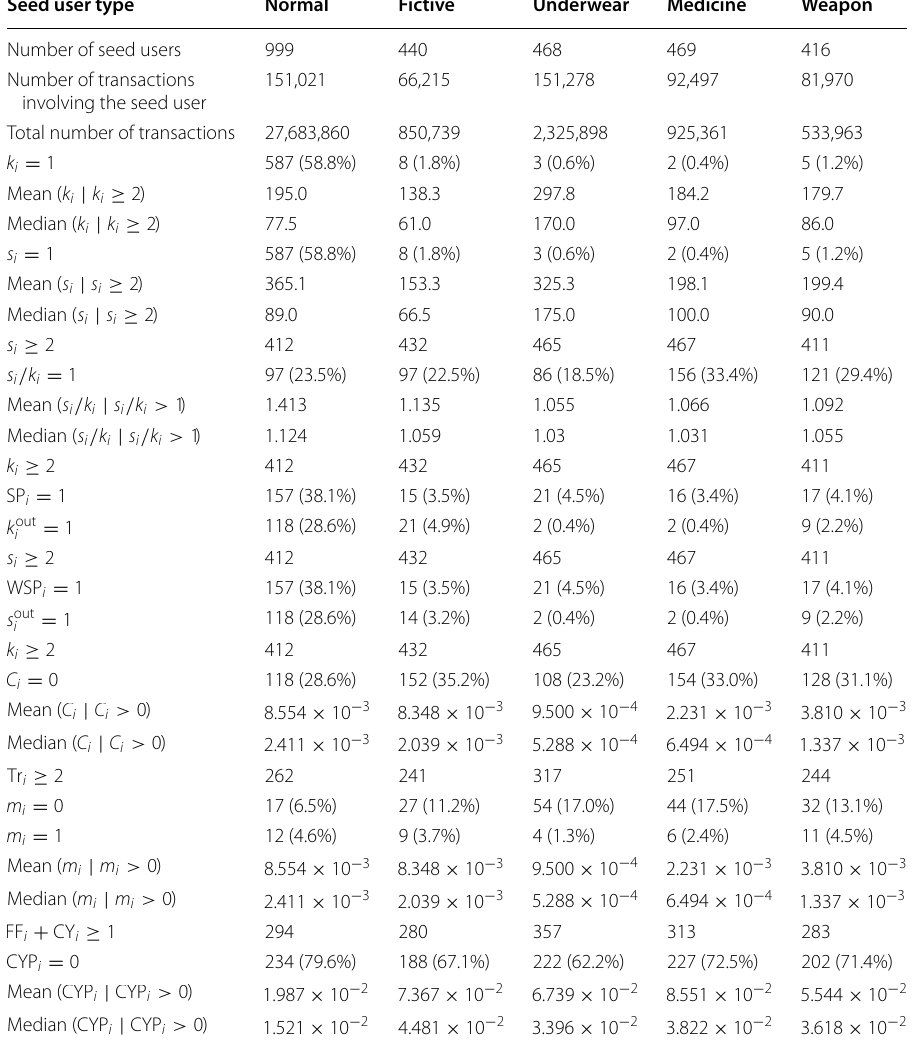
Table 1 Properties of different types of